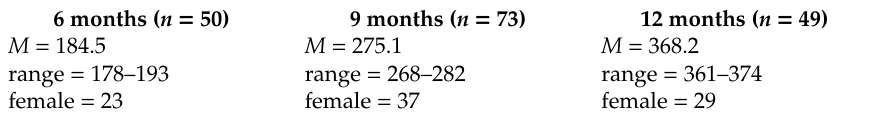
Table 2. Age (in days) and gender details of infant